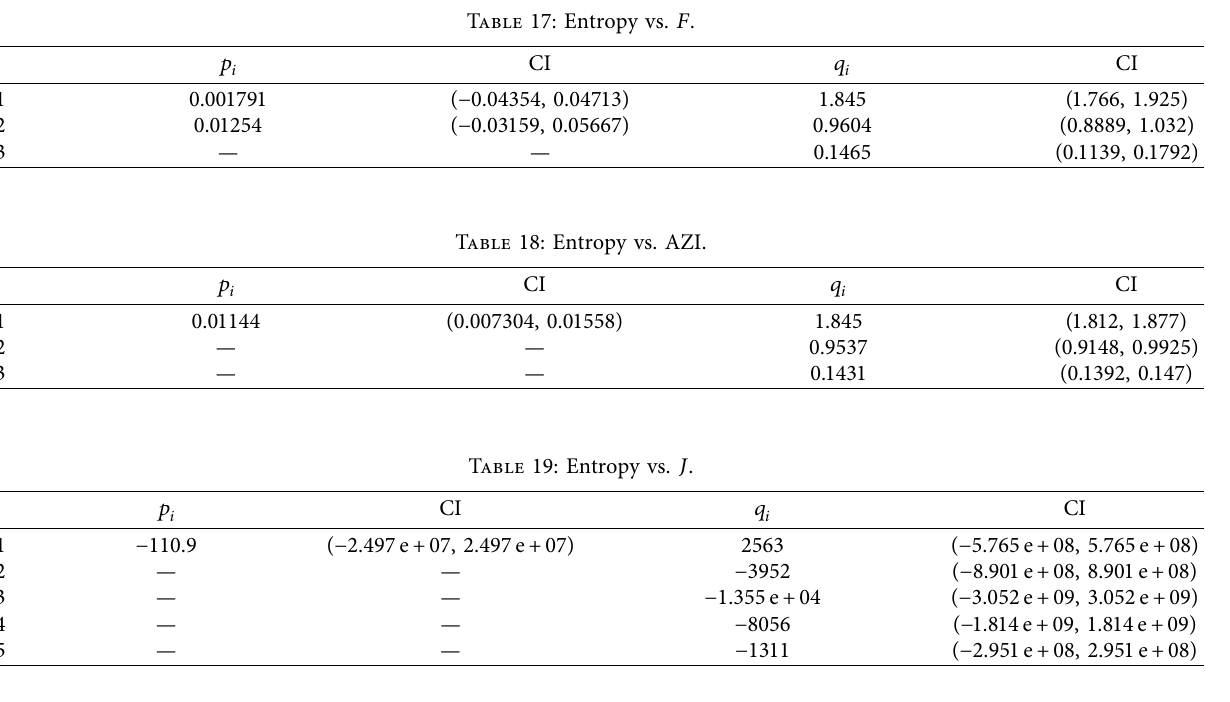
Table 20: Entropy vs. Re G